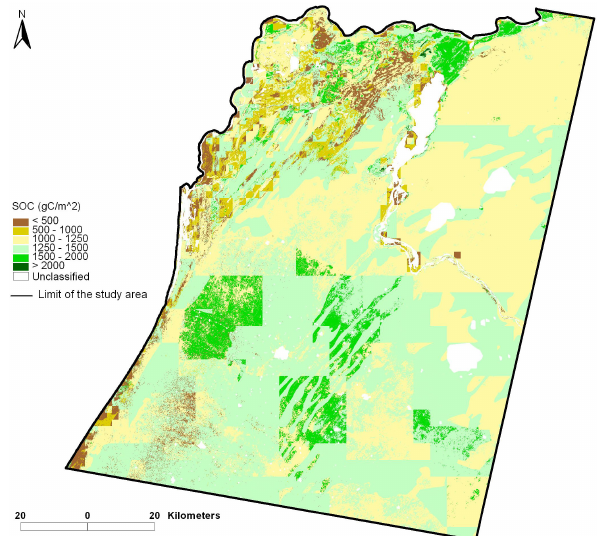
Figure 3 GEMS soil organic carbon (SOC) model output for 2000 using the 9 class 28.5m Landsat hard decision tree classification illustrated in Figure 1 and the corresponding spatially explicit model inputs for the 9 LCLU classes. White shows areas where no SOC was modeled (water bodies, clouds, cloud shadows, settlement areas, or no Landsat data).